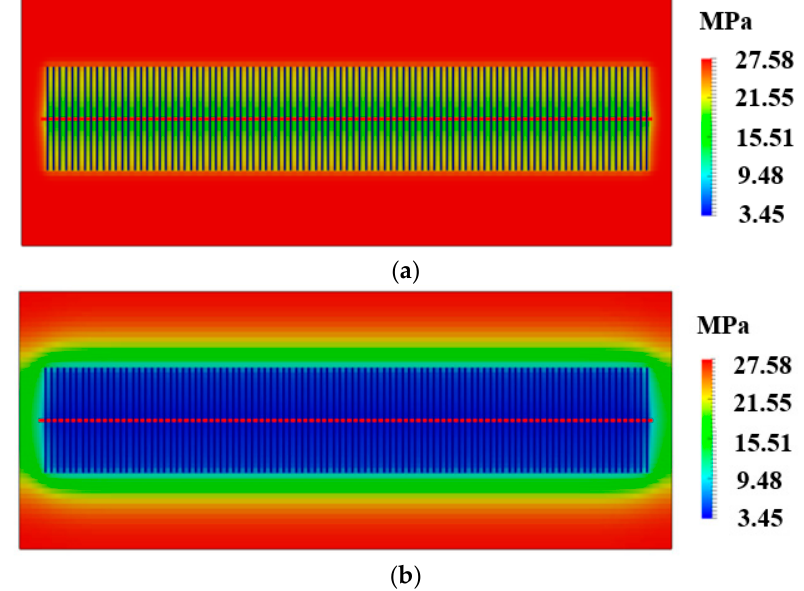
Figure 5. Comparison of pressure distribution at different times: ( a ) After the history-matching period; ( b ) After 30 years of production.